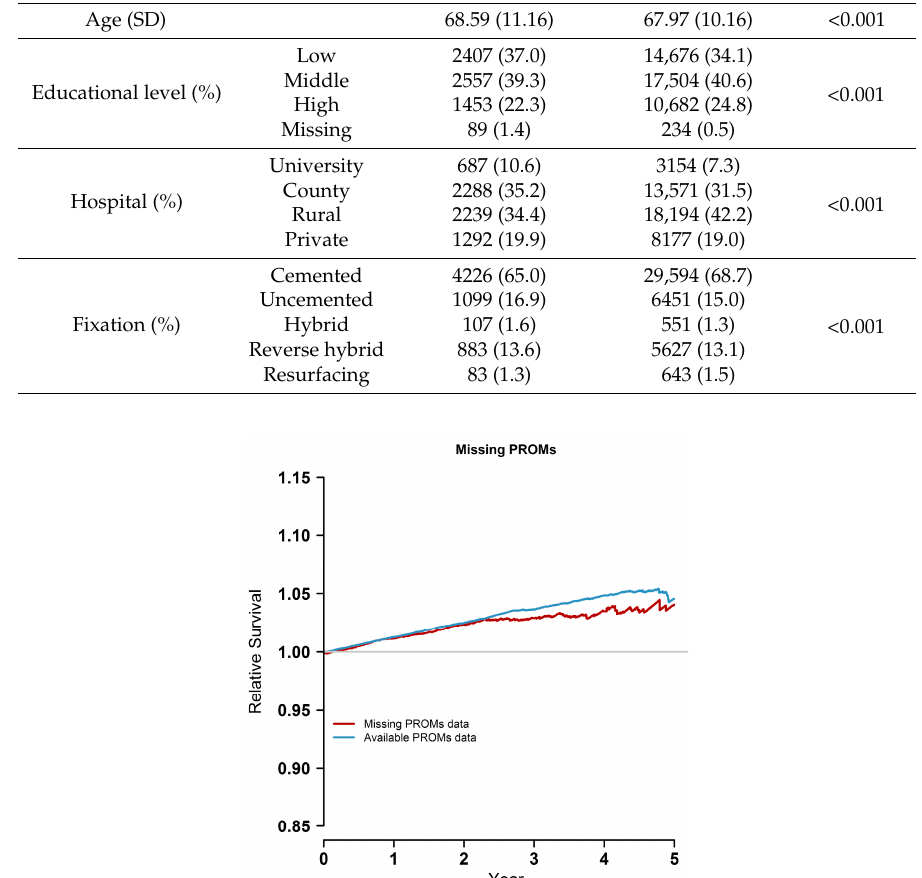
Figure 3. Relative survival curves for the population with missing PROMs and available PROMs. All our survival analyses are based on (present or absent) preoperative recorded